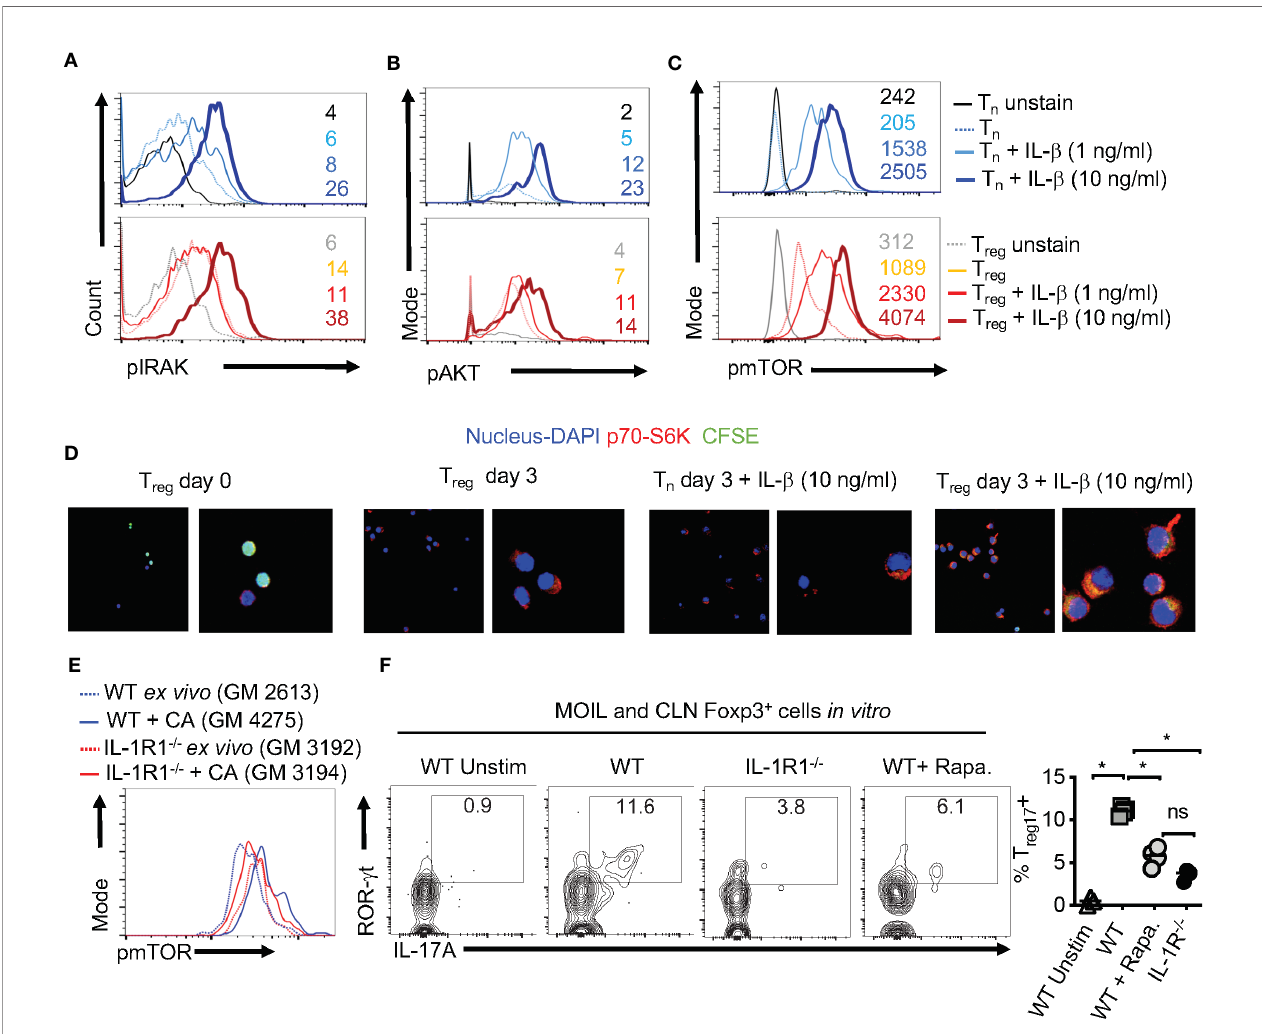
FIGURE 7 | IL-1 b induces IRAK, Akt, TOR, and p-70-S6K activation in T regs (A) Naïve CD4 + T (T n ) and CD4 + CD25 + T reg cells were CFSE labeled and stimulated as in Figure 1C for 3 days without or with IL-1 b . Cells were restimulated with 10 ng/ml of IL-1 b for 4 h before fi xation and staining for p-IRAK (A) , p-Akt (B) , p-mTOR (C) , and p-70-S6K (D) for fl ow cytometry analyses, or cytospun on slides for confocal analyses. (E) Mouse oral intra-epithelial and lamina propria leukocytes (MOILs) were collected from oral CA infected WT and IL-1R1 -/- mice 3 days after infection (n=5/group) and stained for p-mTOR as in (C) . ( F , left and right) Pooled cervical lymph nodes (CLN) and MOIL cells were stimulated with HKGT as in Figure 1C for 5 days with or without Rapamycin (1 ng/ml Rapa). Cells were restimulated with PMA/Ionomycin before intracellular staining and fl ow cytometry analyses (gated on Foxp3 + cells). Geometric mean fl uorescence intensities (GM) are shown with the histogram plots. Data represent triplicate experiments with similar results. NS, non-signi fi cant. *P <